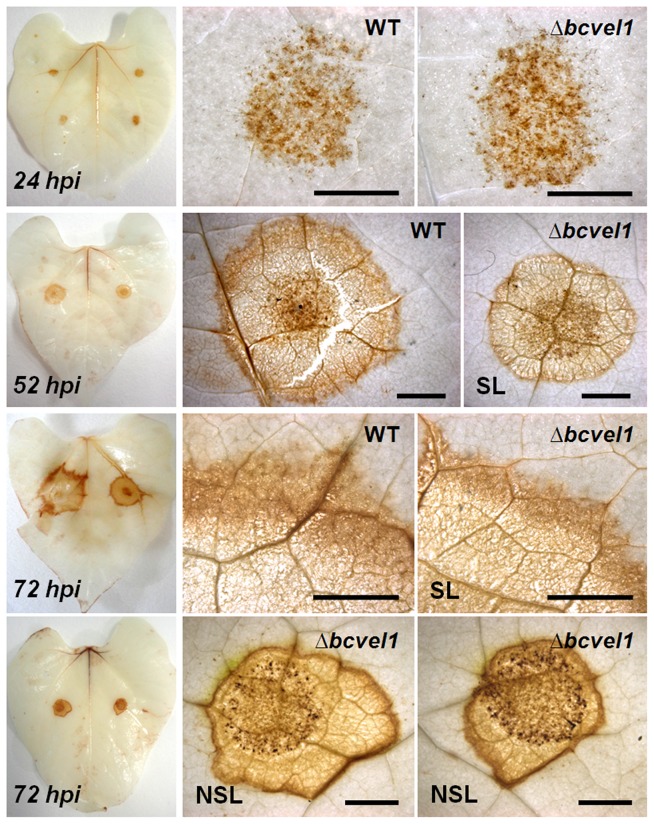
Temporal H2O2 accumulation in spreading (SL) and non-spreading (NSL) lesions.WT:B05.10- and Δbcvel1-infected P. vulgaris leaves were stained with DAB (3,3′-diaminobenzidine) that is oxidized by hydrogen peroxide in the presence of peroxidases to give a dark-brown color. Non-spreading lesions of Δbcvel1 are surrounded by distinct brown rings (lower panels, pictures correspond to non-stained lesions in Fig. 6C). Scale bars represent 2 mm.